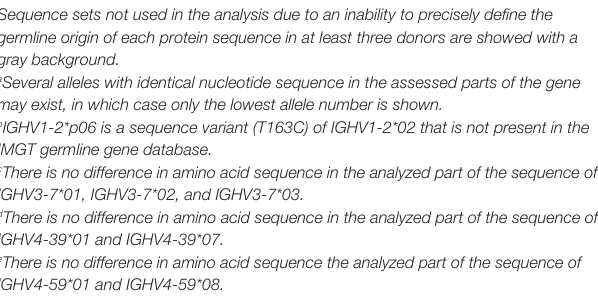
Sequence sets not used in the analysis due to an inability to precisely define the germline origin of each protein sequence in at least three donors are showed with a gray background. a Several alleles with identical nucleotide sequence in the assessed parts of the gene may exist, in which case only the lowest allele number is shown. b IGHV1-2*p06 is a sequence variant (T163C) of IGHV1-2*02 that is not present in the IMGT germline gene database. c There is no difference in amino acid sequence in the analyzed part of the sequence of